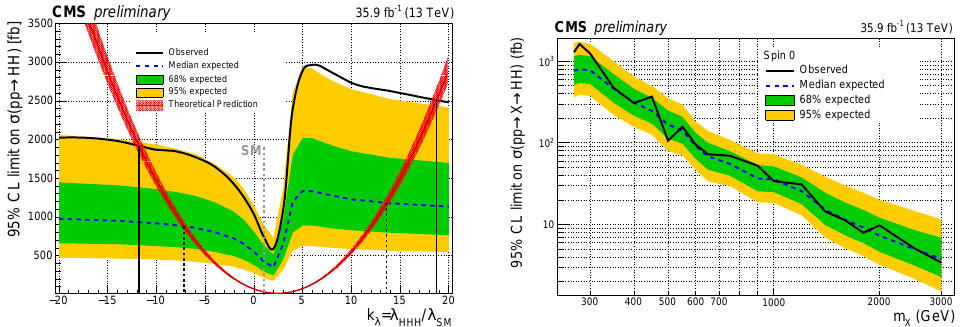
Figure 4. Expected and observed 95% CL upper limits on the non-resonant HH production cross-section as a function of the k λ parameter, that affects both the expected cross-section and the HH decay kinematics, as described in Ref. [19] ( left ) and the exclusion limits on the production of a narrow width spin zero resonance decaying into a pair of Higgs bosons ( right )